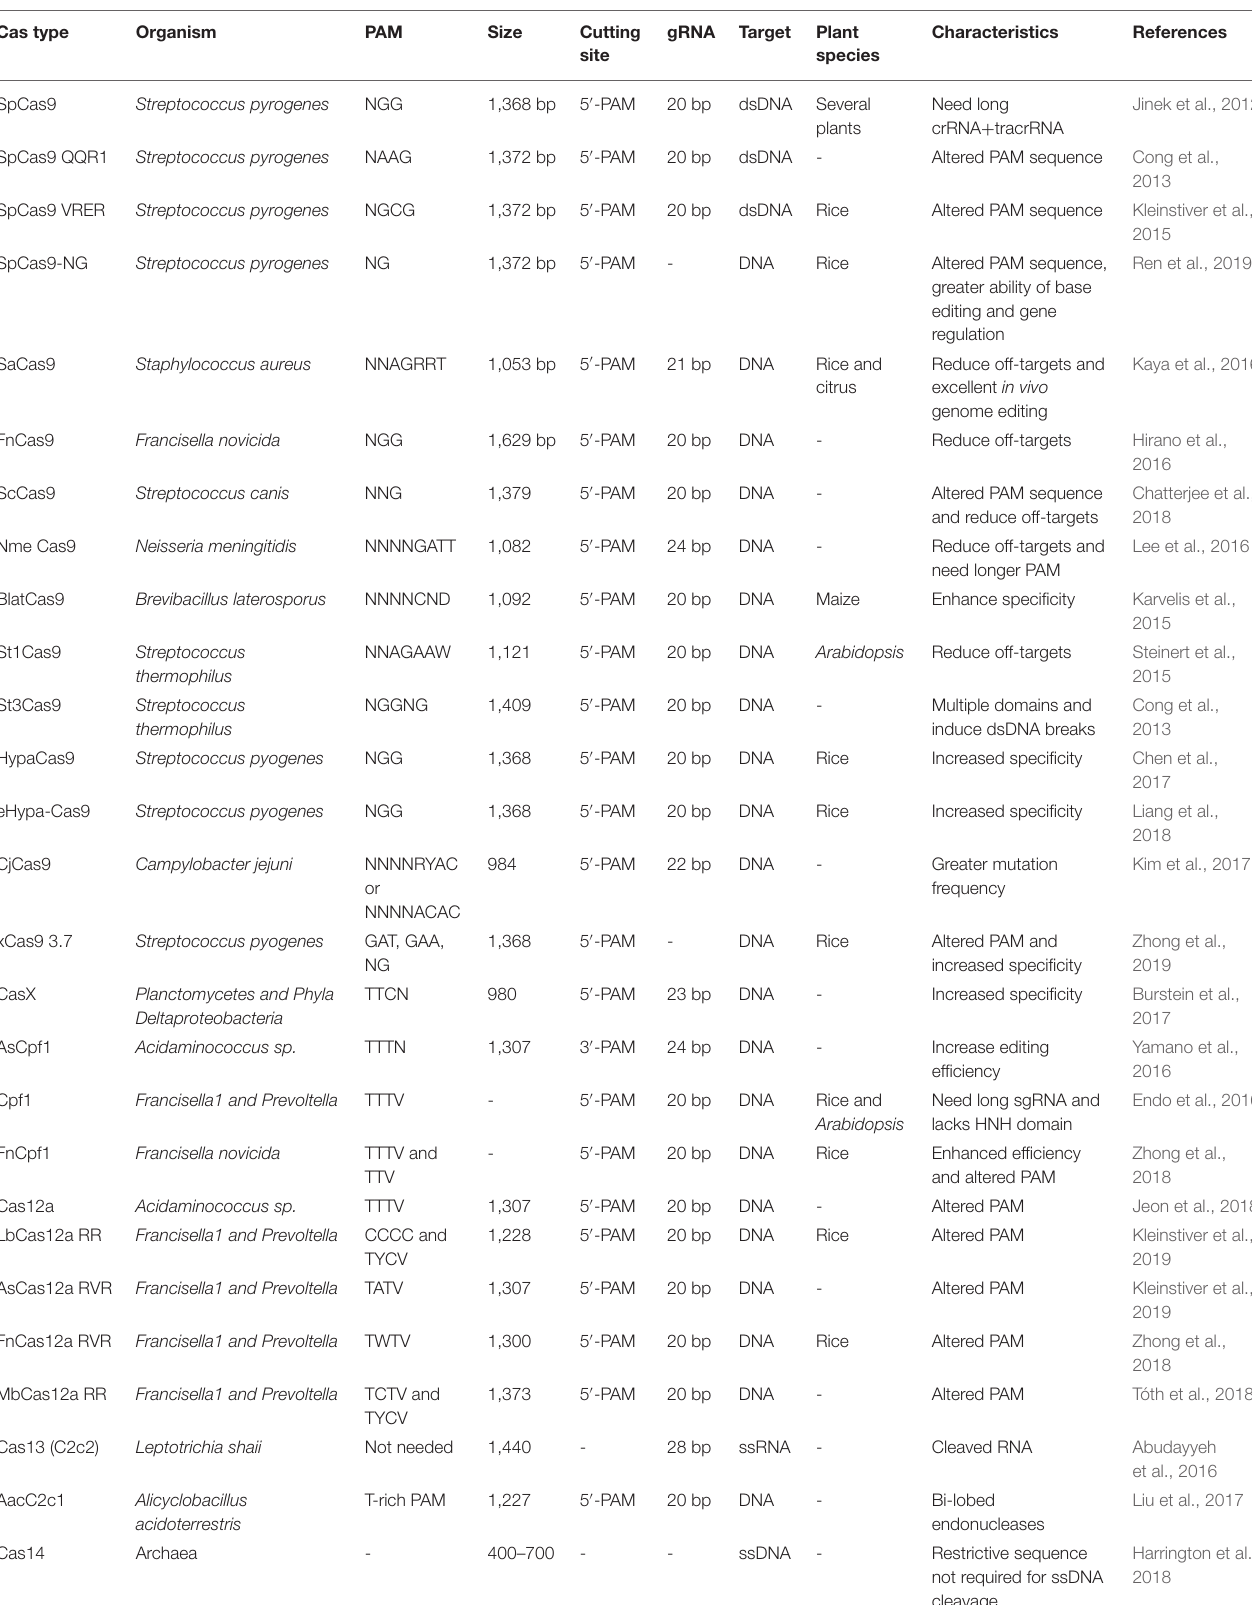
TABLE 3 | List of different Cas orthologs used for plant genome